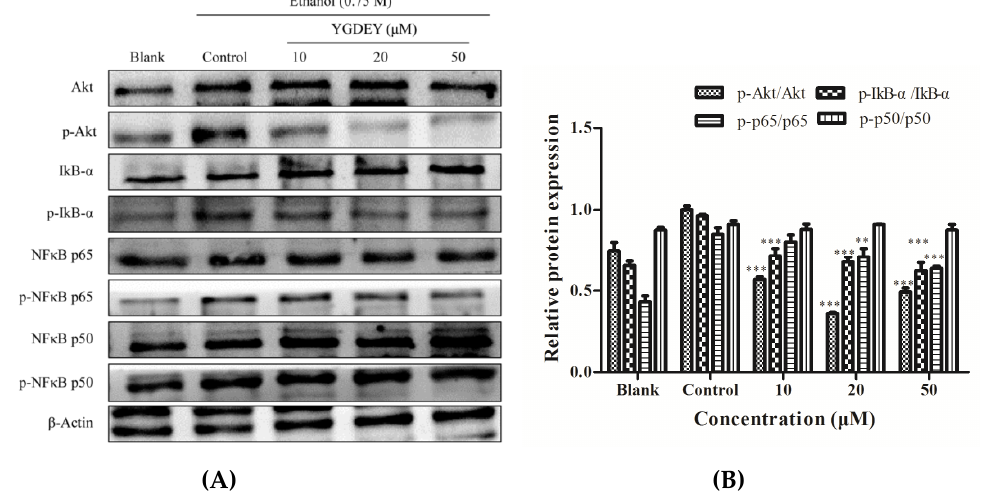
Figure 5. ( A ) Expression changes of phosphor-Akt and phosphor-NF- κ B in HepG2 cells. Cells were exposed to YGDEY (10, 20, and 50 µ M) for 24 h before treatment with 0.75 M ethanol for 2 h. β -Actin was used as an internal control. ( B ) Relative protein expression was normalized. Data are shown as means ± SD ( n = 3). ** compared with the control group, p < 0.01. *** compared with the control group, p < 0.001.